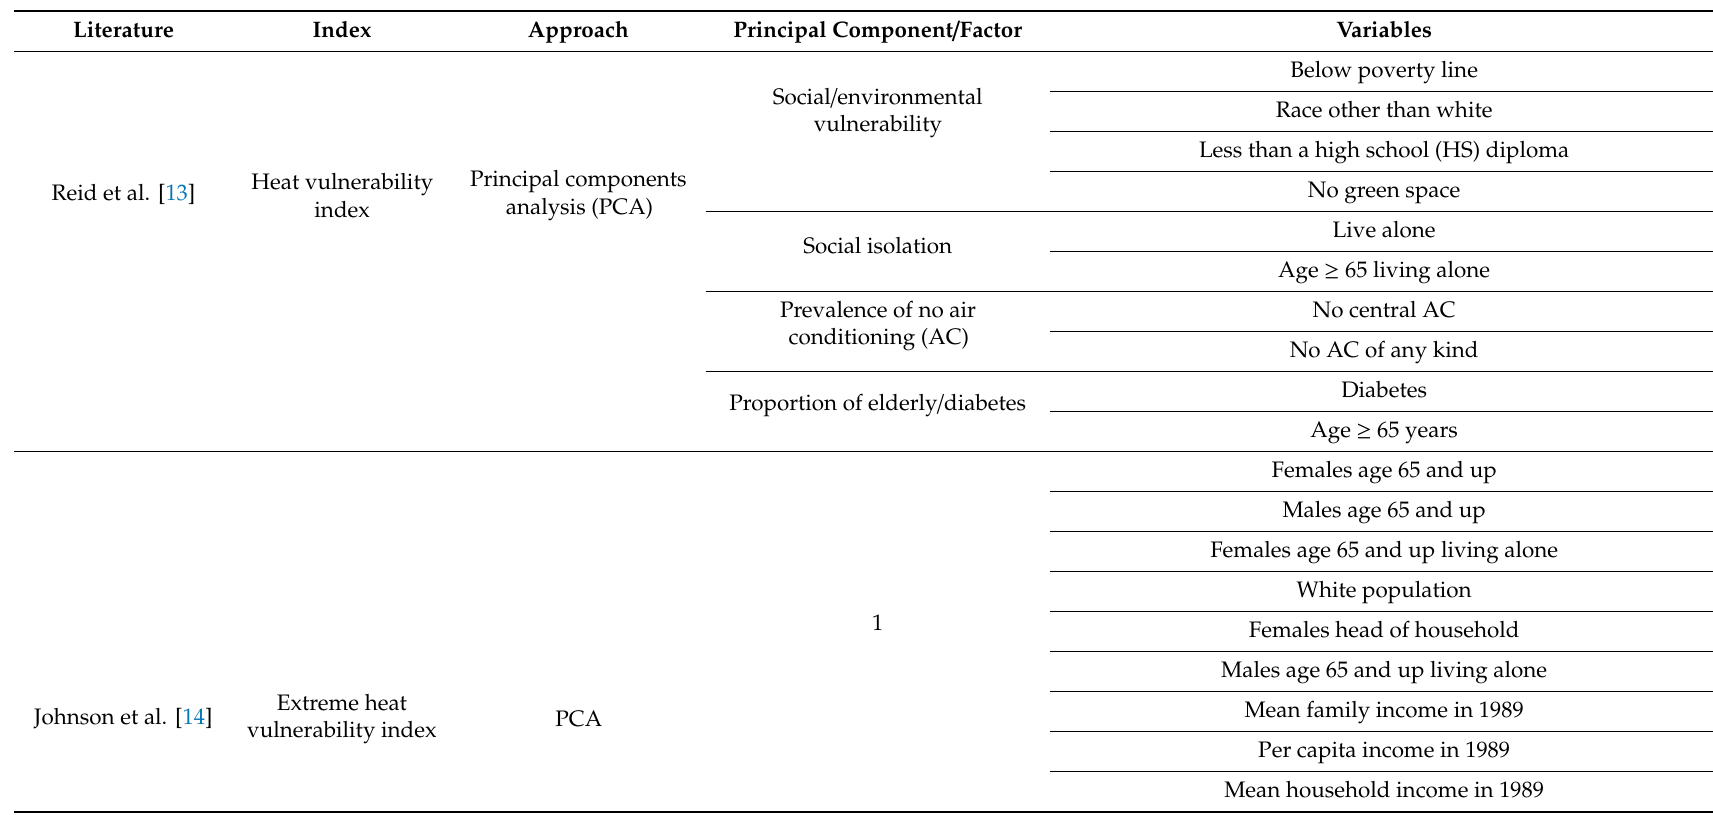
Table 1. Summary of indices and variables for heat vulnerability